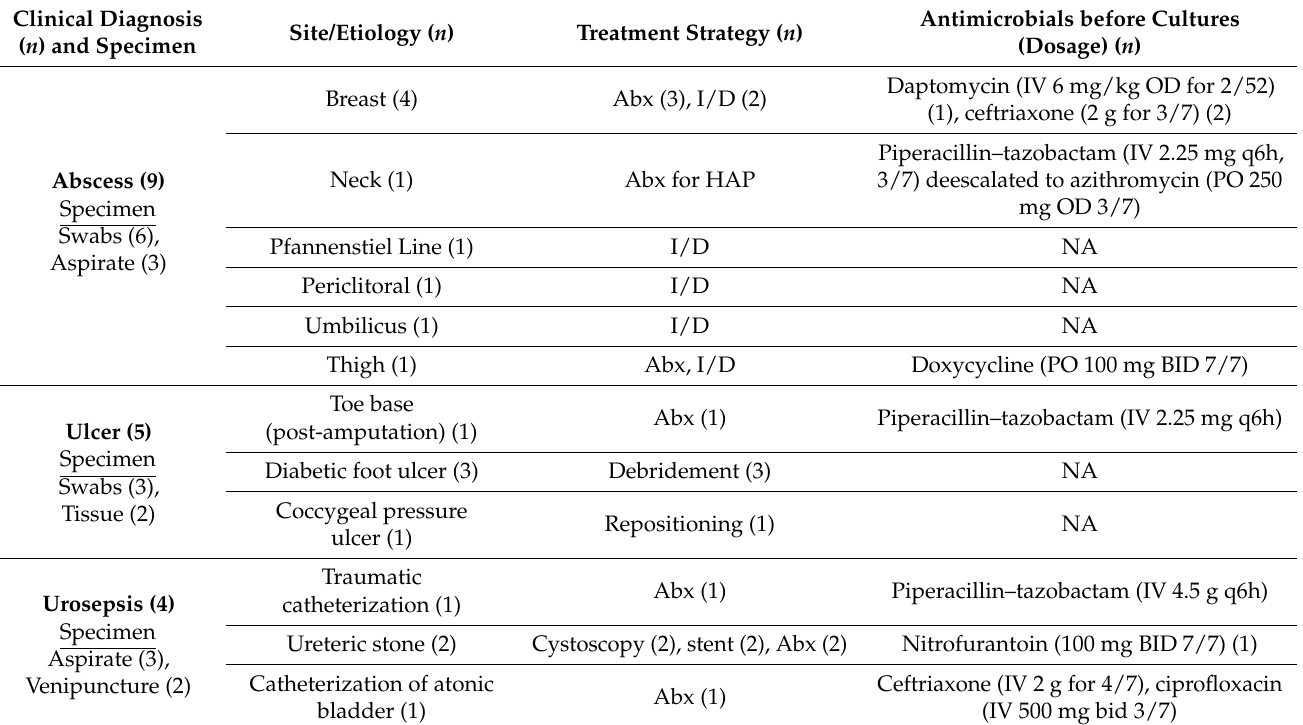
Table 2. Summary of the clinical diagnoses, lab specimens, management strategies, and antimicrobial choices prior to